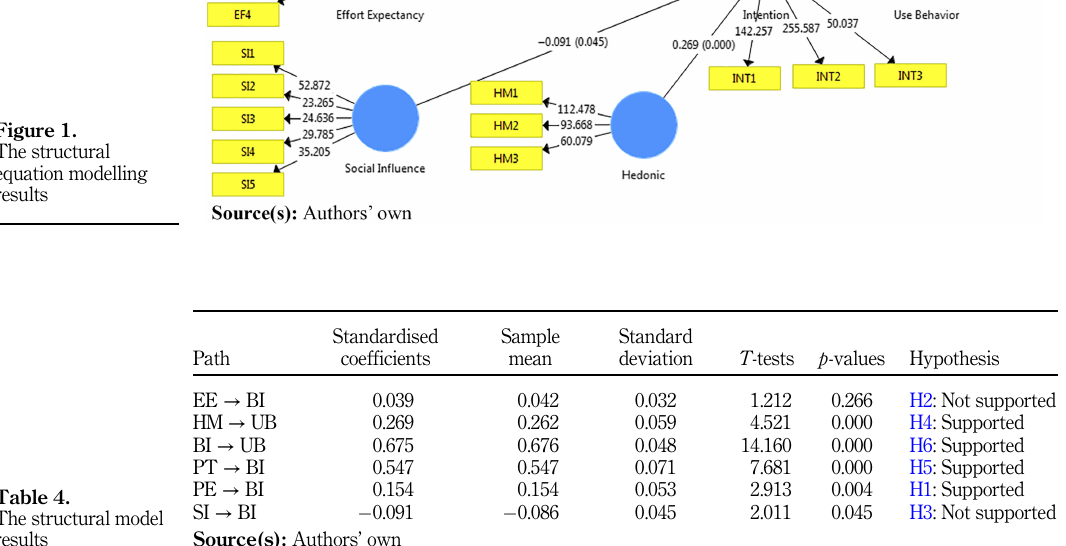
Table 4. The structural model